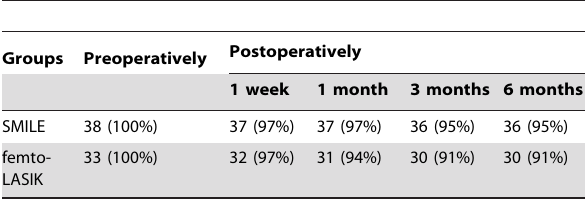
Table 1. Number of eyes evaluated at each examination point.